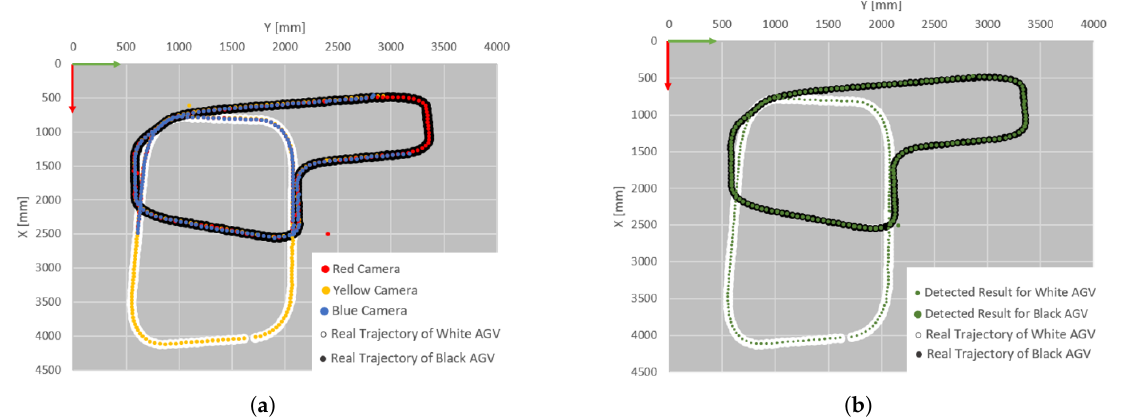
Figure 10. Comparison of detected and real positions during the simulation with multiple robot: ( a ) results for every camera; ( b ) average